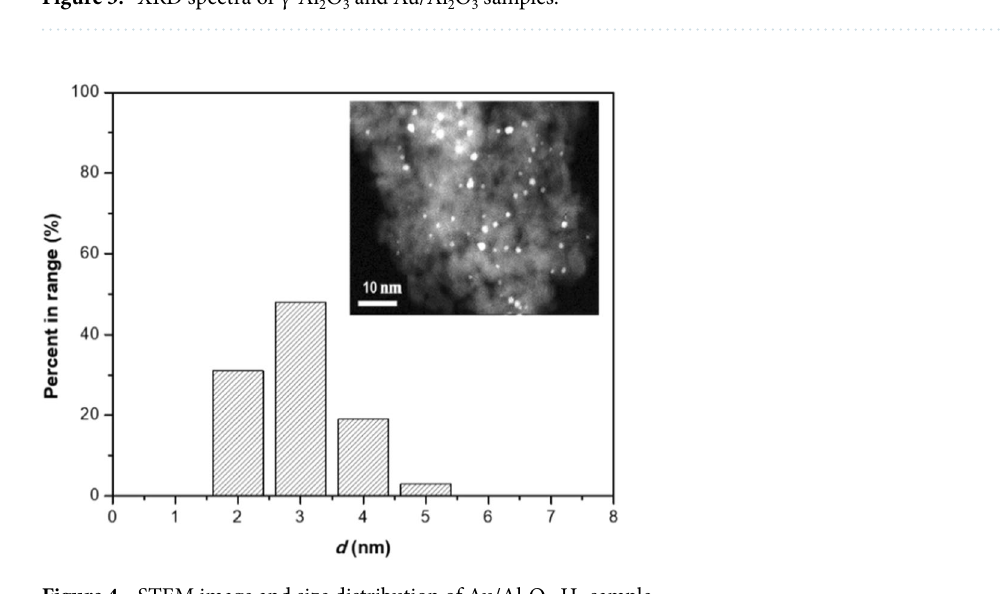
Figure 3. XRD spectra of γ-Al 2 O 3 and Au/Al 2 O 3 samples.